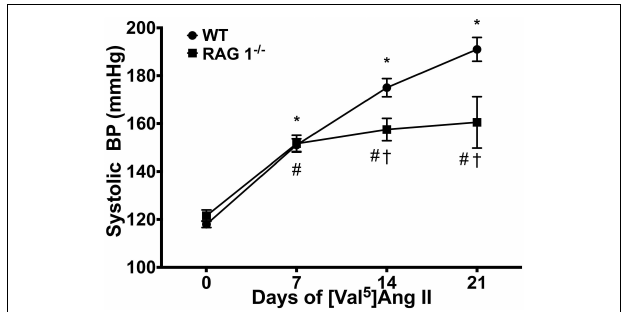
FIGURE 2 | Blood pressure. Systolic blood pressures were measured by tail cuff in WT and RAG 1 − / − over the [Val 5 ]Ang II treatment. N = 15 –47. * P < 0 . 05 vs. day 0 of WT; # P < 0 . 05 vs. day 0 of RAG 1 − / − ; † P < 0 . 05 between different strains at each time point. Data are means ±